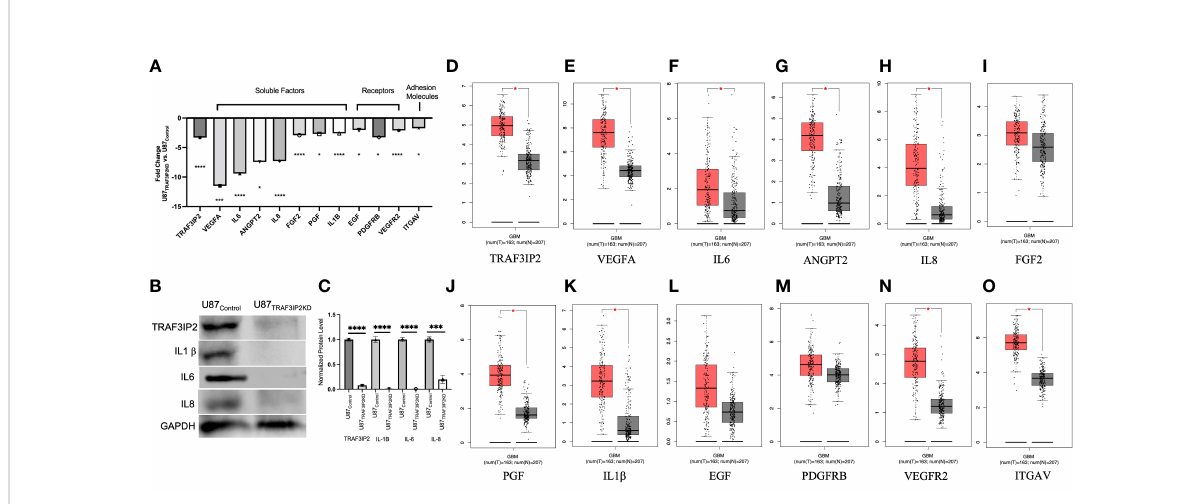
FIGURE 4 Targeting TRAF3IP2 in GBM decreases pro-angiogenic factors and receptors. Gene expression fold changes (U87 TRAF3IP2KD vs. U87 Control shRNA ) are shown. *p < 0.05, ***p < 0.001, ****p < 0.0001 (A) . Protein levels of key angiogenic factors in U87 TRAF3IP2KD vs. U87 Control (B) and quanti fi cation (C) . Levels of key angiogenic factors in GBM vs. normal tissue: clinical GBM tumor samples and data (red bars) are from The Cancer Genome Atlas (TCGA) red bars and normal controls (gray bars) are from Genotype-Tissue Expression (GTEx) accessed through GEPIA (http://gepia.cancer-pku.cn), p < 0.01 (D – O)